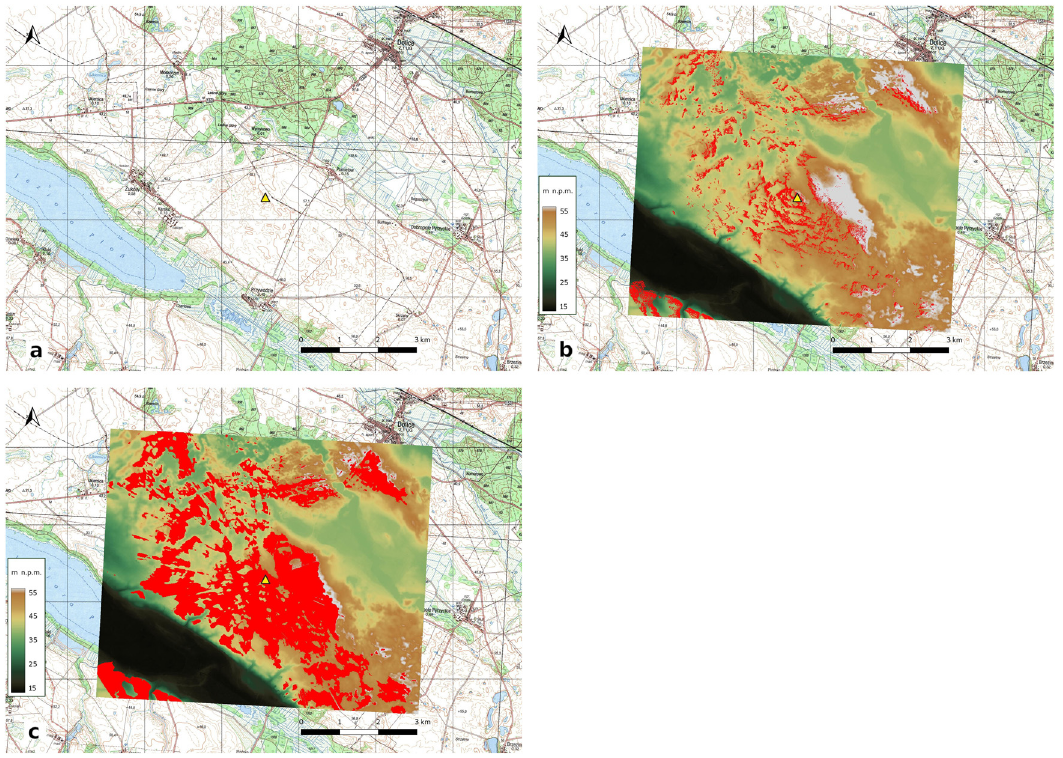
Figure 3: Megalithic tomb at Karsko. Location of the structure ( a ) the area visible from the tomb ( b ) and the area from which the tomb is visible ( c ) ( M. Schiller )